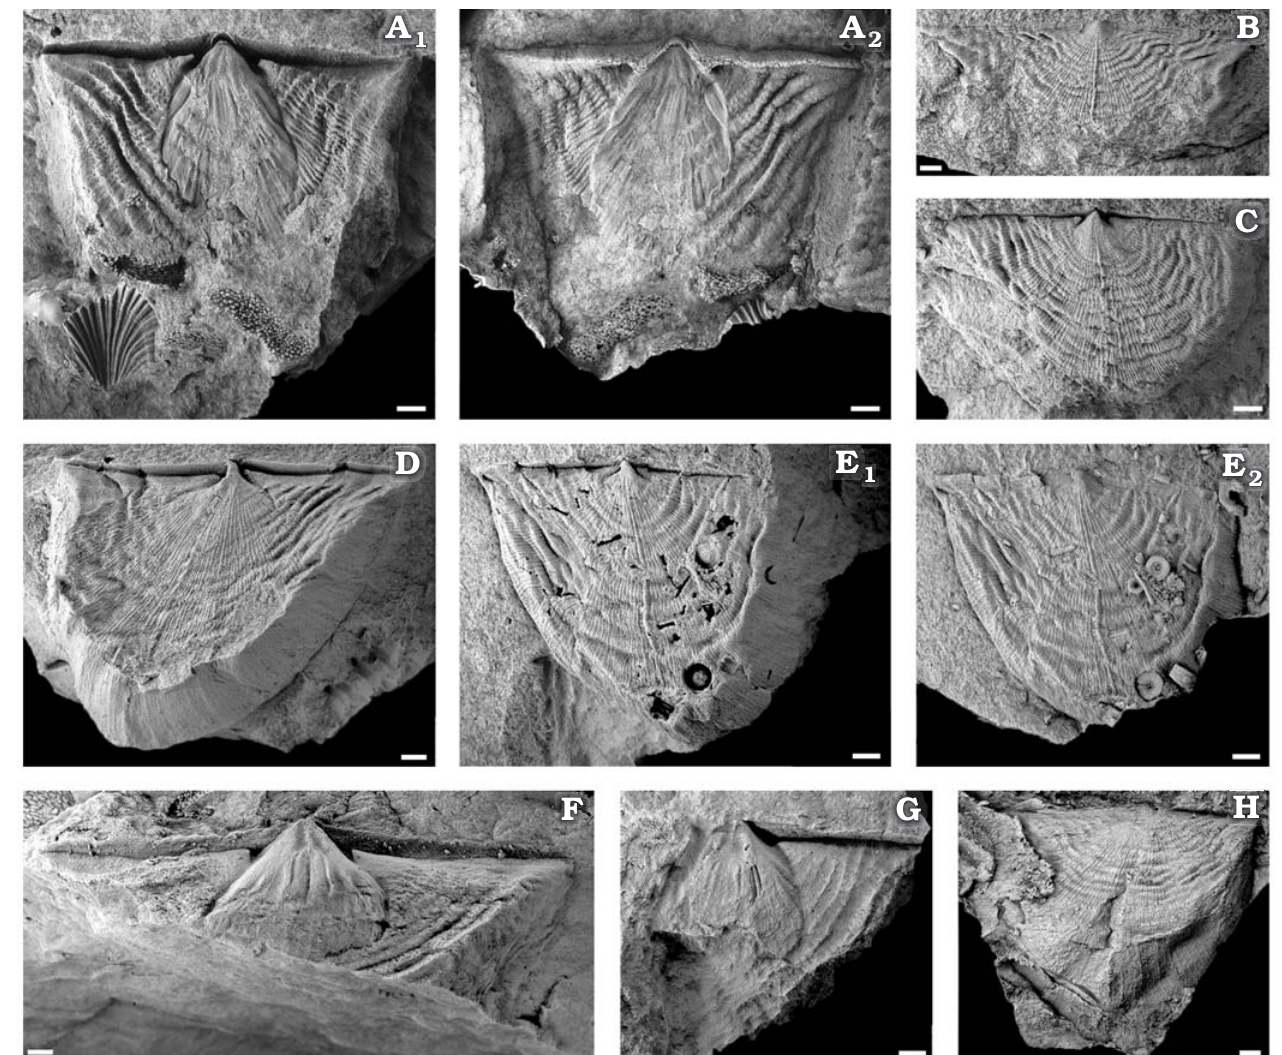
Fig. 8. Ventral valves of rafinesquinine brachiopod Kjaerina ( Villasina ) pedronaensis sp. nov.; Katian, Upper Ordovician; Portixeddu Formation at